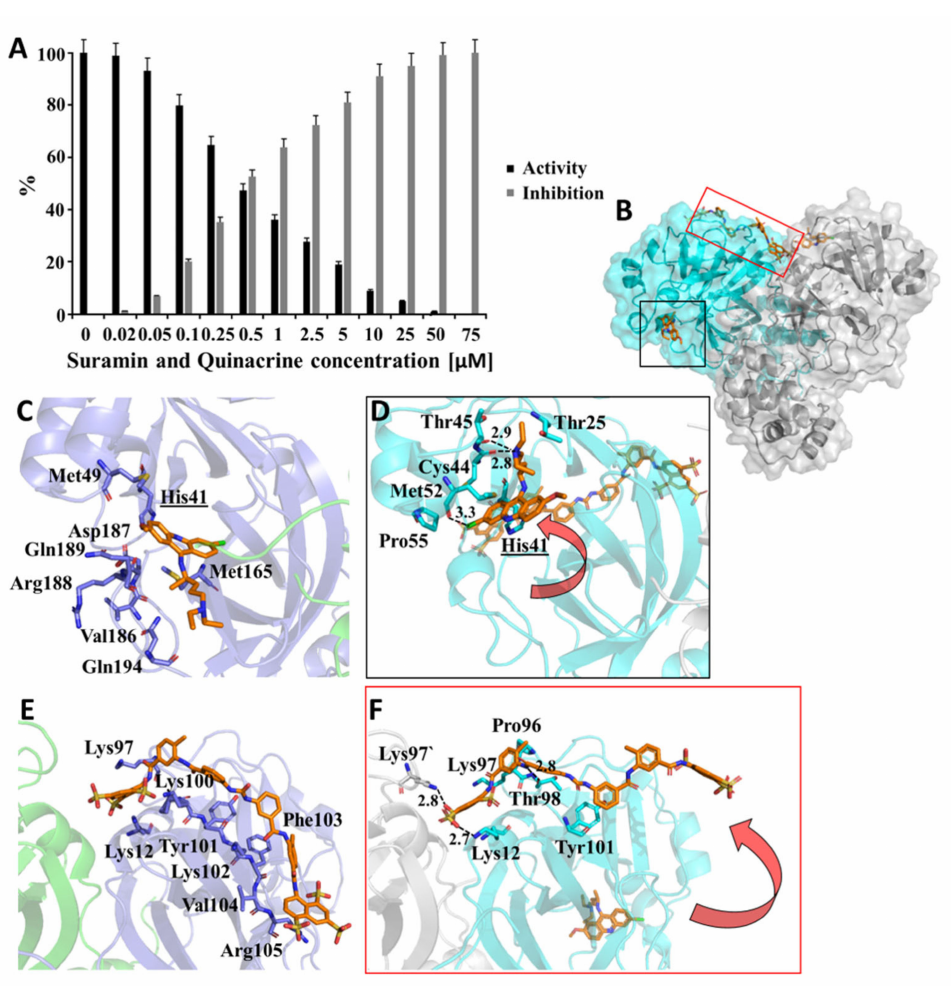
Figure 8. SARS-CoV-2 3CL pro inhibition by a combination of quinacrine and suramin. ( A ) Nor- malized activity and inhibition of SARS-CoV-2 3CL pro under quinacrine and suramin influence. Data shown are mean ± SD from 3 independent measurements ( n = 3). ( B ) Ribbon and surface representation of the SARS-CoV-2 3CL pro model (grey/cyan) (PDB entry: 6M2Q) in complexes with suramin and quinacrine (sticks in orange). ( C ) SARS-CoV-2 3CL pro amino acids involved in the interaction with quinacrine. ( D ) SARS-CoV-2 3CL pro amino acids involved in the interaction with quinacrine under the influence of a simultaneous suramin interaction. ( E ) SARS-CoV-2 3CL pro amino acids involved in the interaction with suramin. ( F ) SARS-CoV-2 3CL pro amino acids involved in the interaction with suramin under the influence of a simultaneous quinacrine interaction. ( C – F ) are based on MD